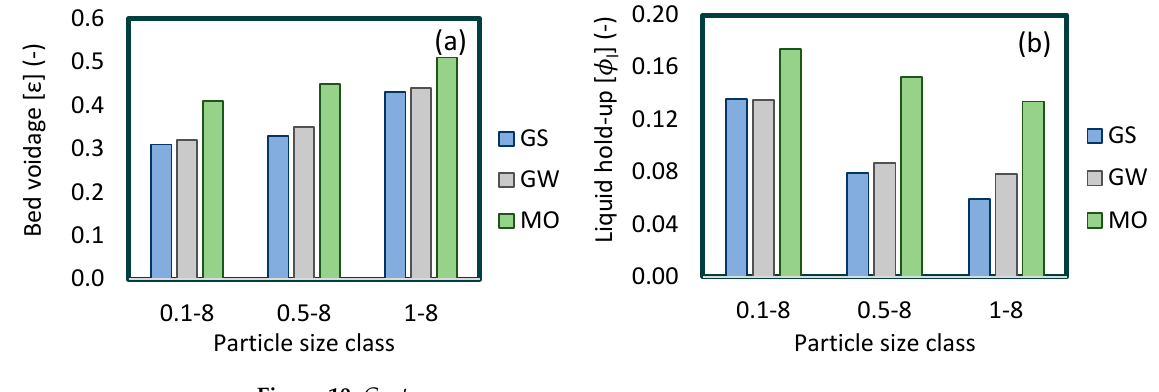
Figure 10. ( a ) Bed voidage, ( b ) total liquid hold-up, ( c ) 24-h drain-down moisture as percentage of total liquid hold-up, and ( d ) solution breakthrough time characterisation data for beds composed of different size fractions of GSs, GW, and MO. Key: 0.1-8 (0.1–8 mm), 0.5-8 (0.5–8 mm), and 1-8 (1–8 mm). 3.3. Effect of the Systematic Exclusion of Fines Figures 9 and 10 show the effect of systematically excluding fines from the particle size distribution of mixed sized beds. Increasing the bottom size limit of the non-porous GS and moderately porous GW beds from 0.1 to 1 mm brought about significant reduc- tions in their total liquid hold-up (43%–57%), solution (75%–80%), and tracer (80%–90%) breakthrough times. Though the liquid hold-up for the 0.5–8 mm and 1–8 mm systems (excluding the MO beds) are similar, differences in their (GS and GW) steady-state RTD curves (Figure 9c,e) are noticeable. This suggests an increase in the formation of isolated fluid volumes with the decrease in the presence of agglomerated fines for the less porous beds. The MO systems’ RTD responses were more resistant to changes in bottom particle size. In fact, the RTD profiles for the MO-0.1-8 and MO-0.5-8 beds are nearly identical. It is only when the bottom size was further raised to 1 mm that a reduction in the tracer breakthrough time was observed. Furthermore, the MO system experienced the lowest reduction in total liquid hold-up (29%) and solution breakthrough time (27%) with the increase in bottom particle